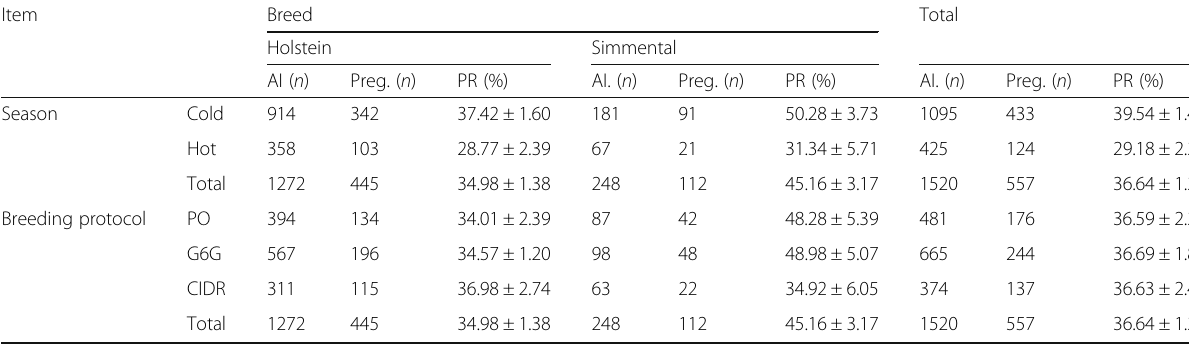
Table 2 Distribution and descriptive statistics of the cows included in this